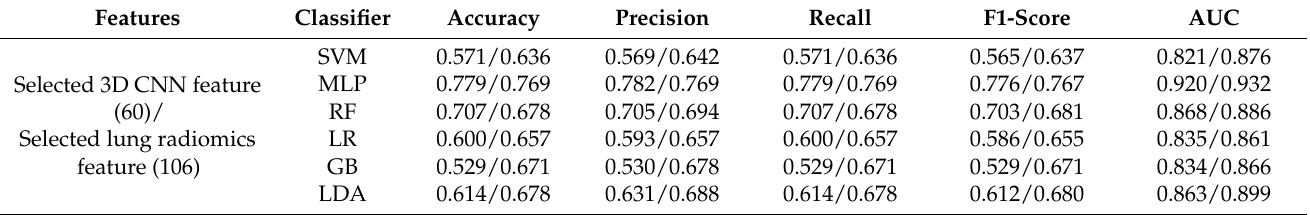
Table 5. The different ML classifiers’ performance on the test set of fused 3D CNN features (60) or lung radiomics features (106) generated by the PCA algorithm in Experiment 1.